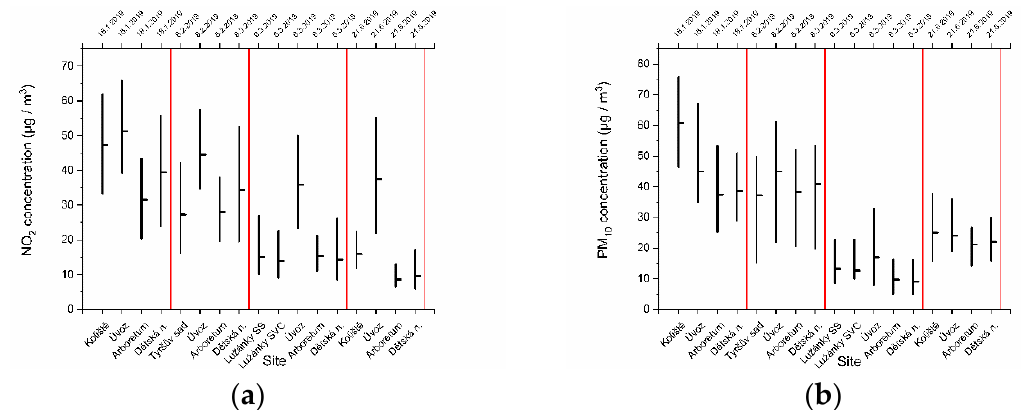
Figure 7. The NO 2 ( a ) and PM 10 ( b ) concentrations in the parks and at the automated air pollution monitoring sites. monitoring